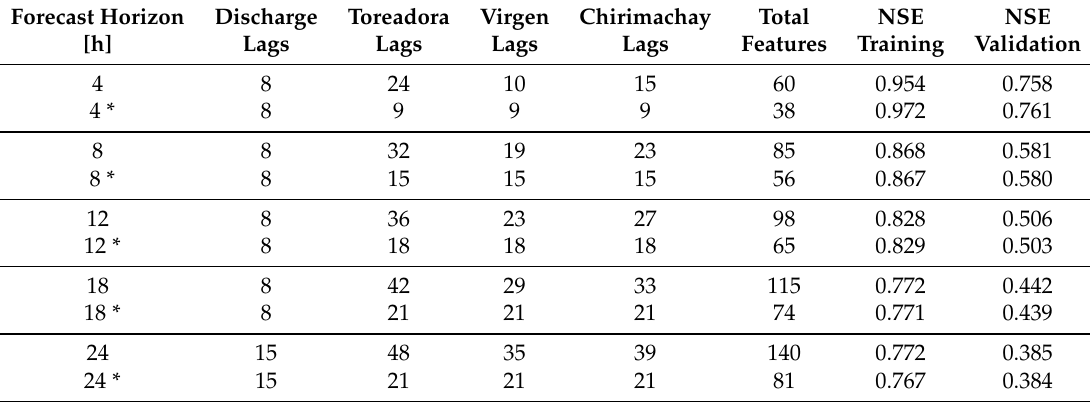
Table 2. Input data composition and model efficiencies for forecasting models and their parsimonious versions for prediction horizons of 4, 8, 12, 18 and 24